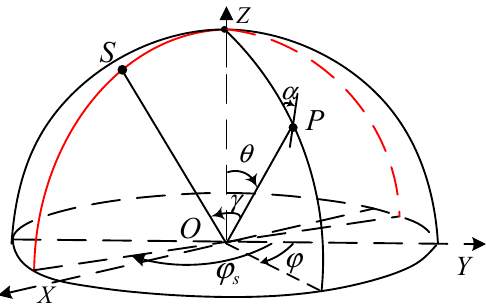
Figure 2. Geometric relationships of skylight polarization mode and beams.